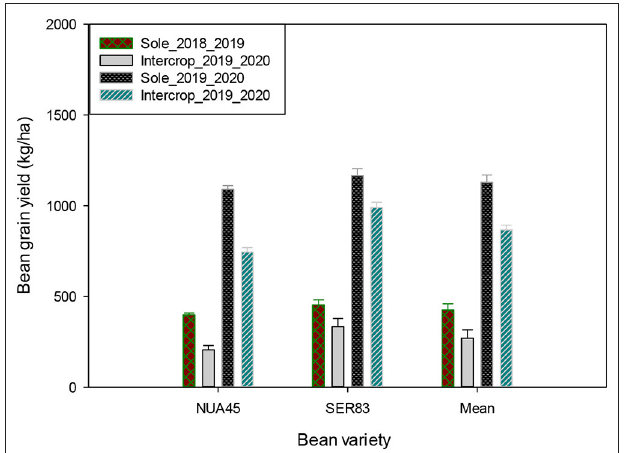
FIGURE 2 | Grain yield (kg/ha) between two newly released common bean varieties NUA45 and SER83 under sole and intercropping systems with a maize variety SC672 evaluated at Chitedze and Linthipe during the 2018/2019 and 2019/2020 growing seasons.